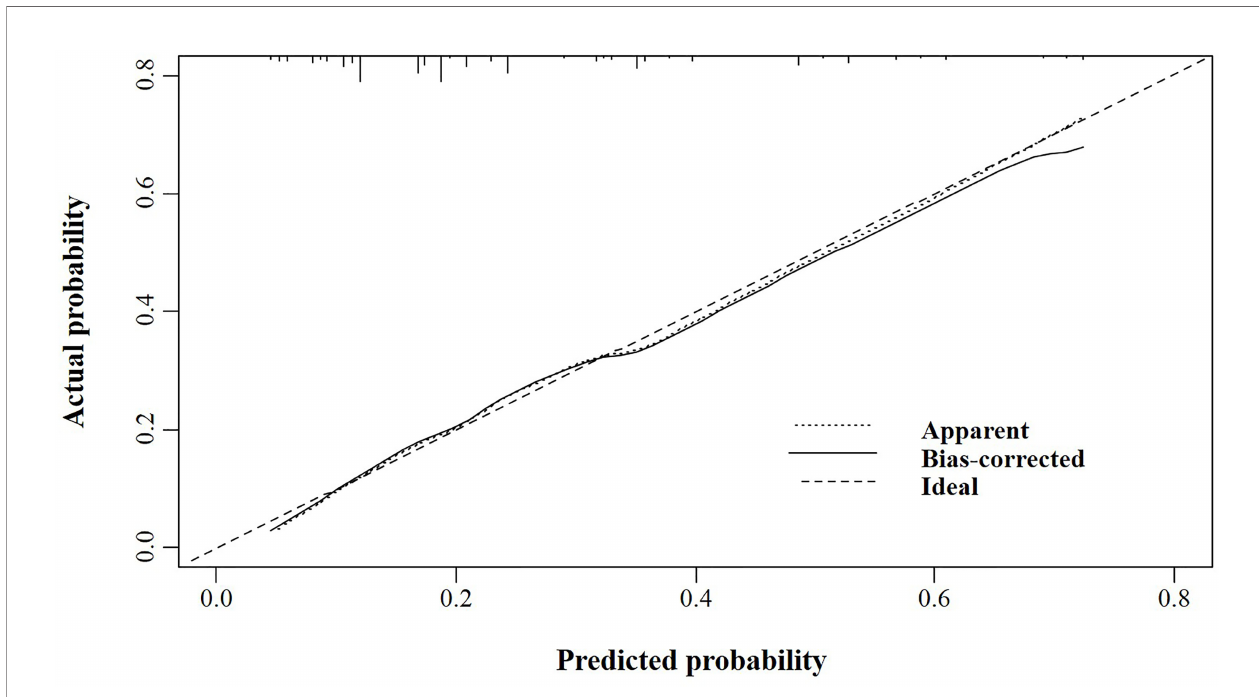
FIGURE 3 | The calibration curve for assessing the calibration of the nomogram in predicting all cause of early death in the construction cohort.